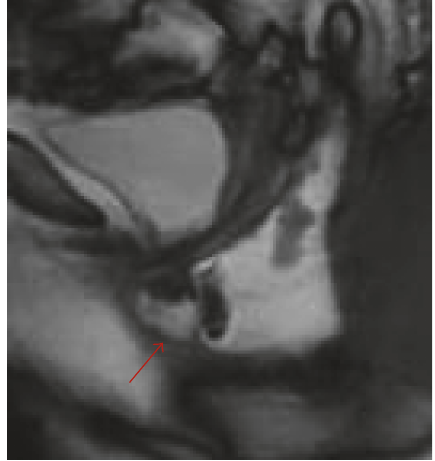
Figure 3: Persistent large size rectocele and contemporary depiction of a rectal pocket (arrow) developed as result of STARR